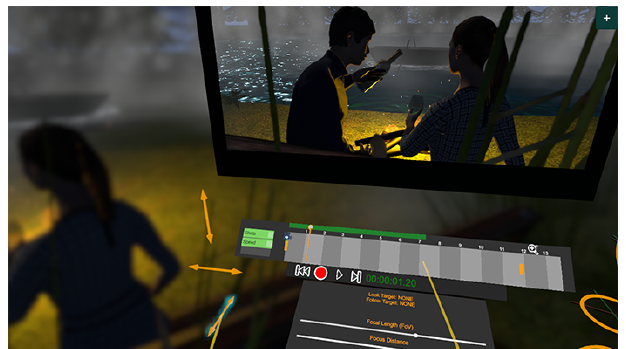
Figure 22. View from the “Through the Len”